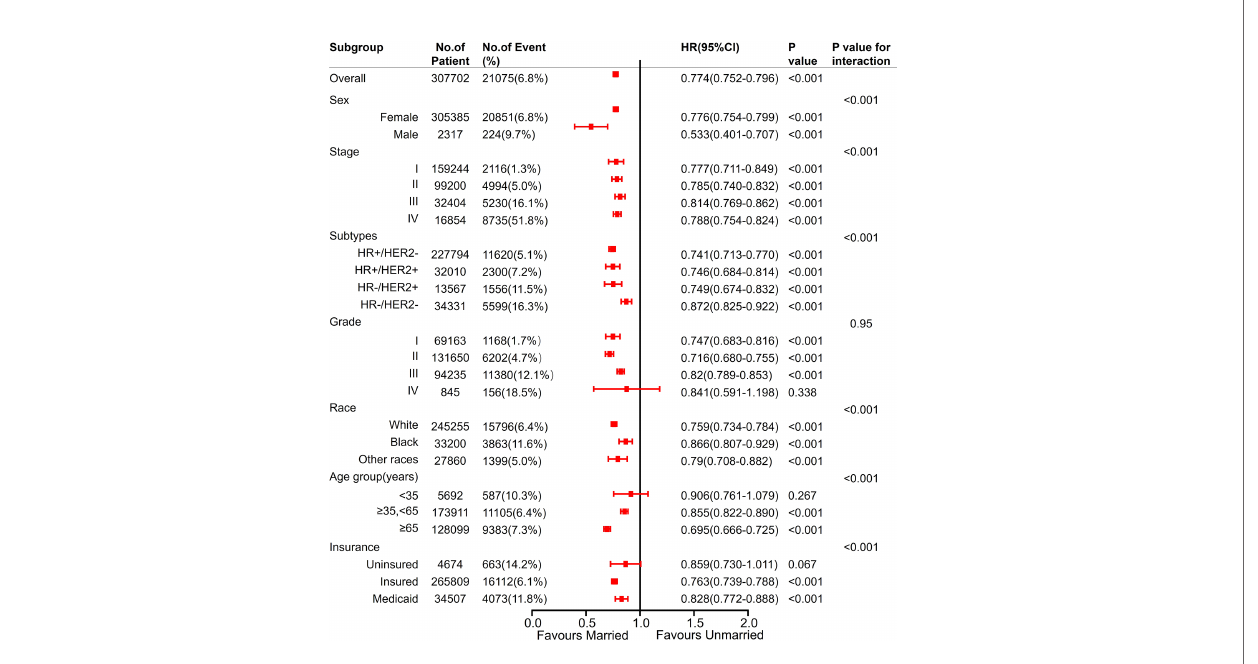
FIGURE 7 | Analyses of BCSS (breast cancer-speci fi c survival) for married vs unmarried patients in each subgroup after adjusted by other clinicalpathological factors. Hazard Ratio (HR) estimates for BCSS are indicated by rectangles, and 95% con fi dence intervals (95% CI) are indicated by the crossing horizontal